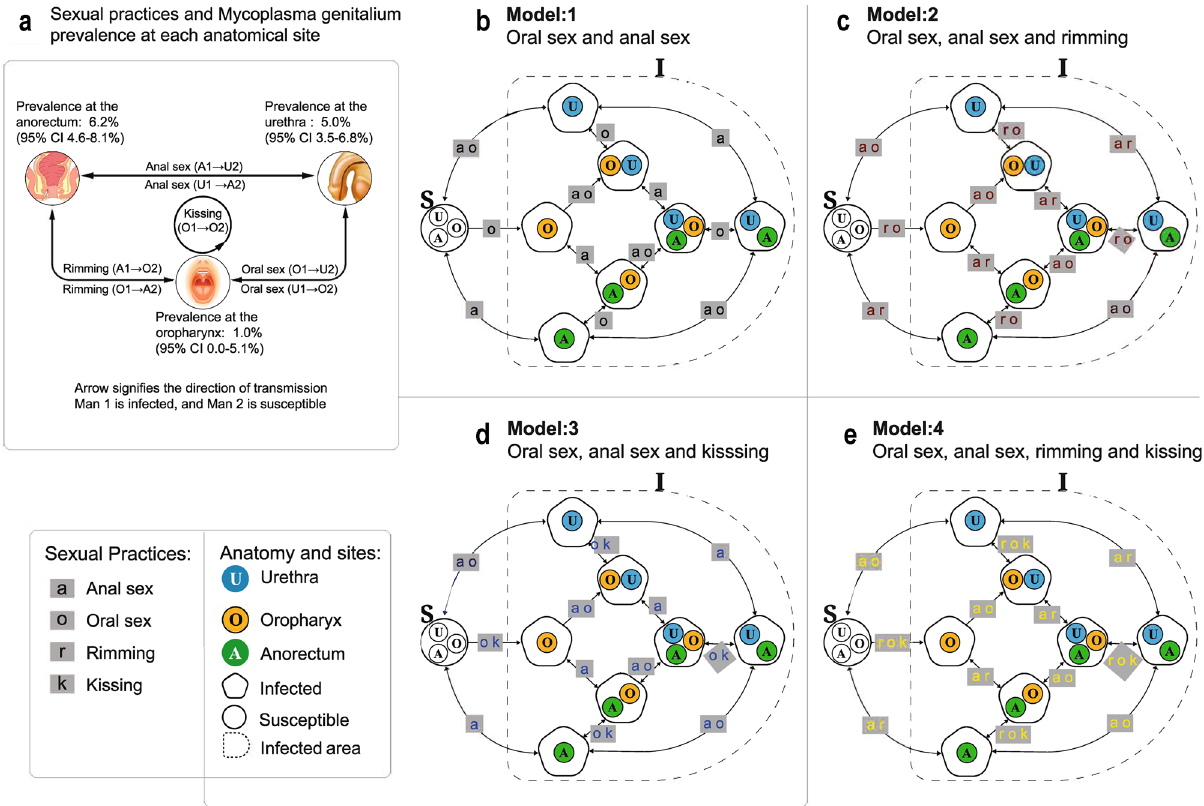
Figure 3. Sexual practices, site-specific prevalence, and model structure. ( a ) Sexual practices and site-specific prevalence. Man 1 is infected, and Man 2 is susceptible; U = urethra, A = anorectum, O = oropharynx; The numerical subscript number (1 or 2) refers to Man 1 or Man 2 (e.g. A1 = anorectum of man 1); Site-specific prevalence was from Sexually Transmitted Infections (2020; sextrans-2019-054310); ( b ) Model 1: Only oral sex and anal sex transmit Mycoplasma genitalium ; ( c ) Model 2: Only oral sex, anal sex and rimming transmit Mycoplasma genitalium ; ( d ) Model 3: Only oral sex, anal sex and kissing transmit Mycoplasma genitalium ; ( e ) Model 4: Oral sex, anal sex, rimming, and kissing transmit Mycoplasma genitalium